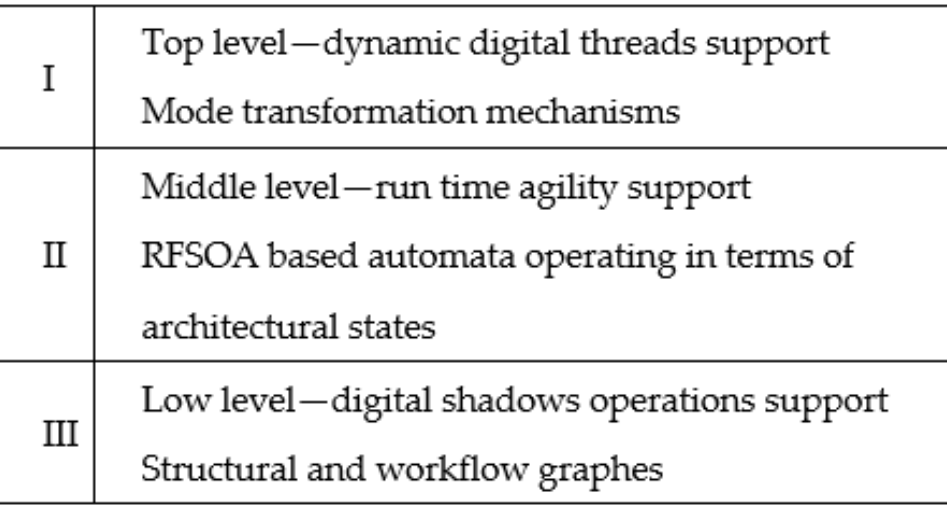
Figure 2. Three-level DDTh model.